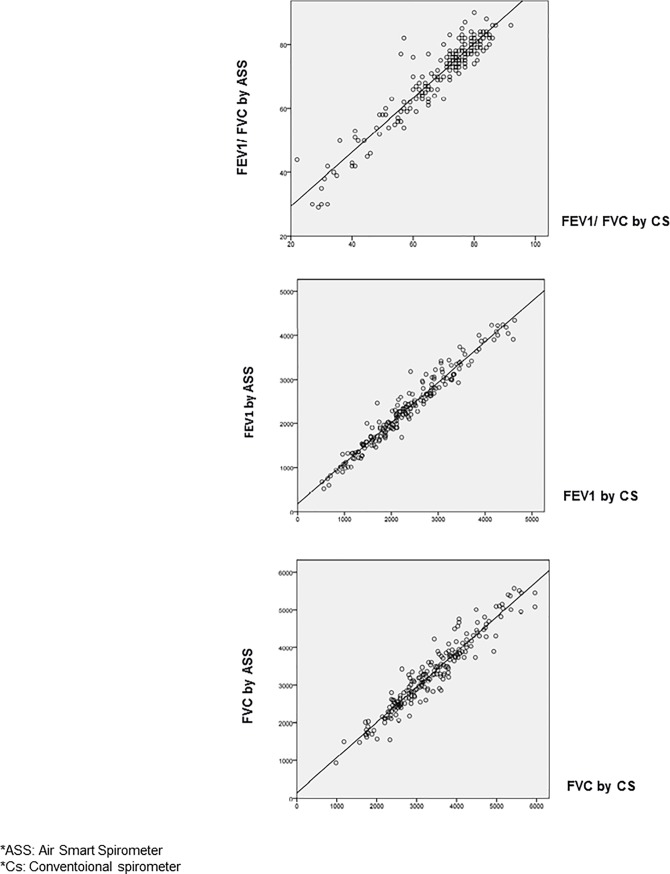
Correlation graphs.